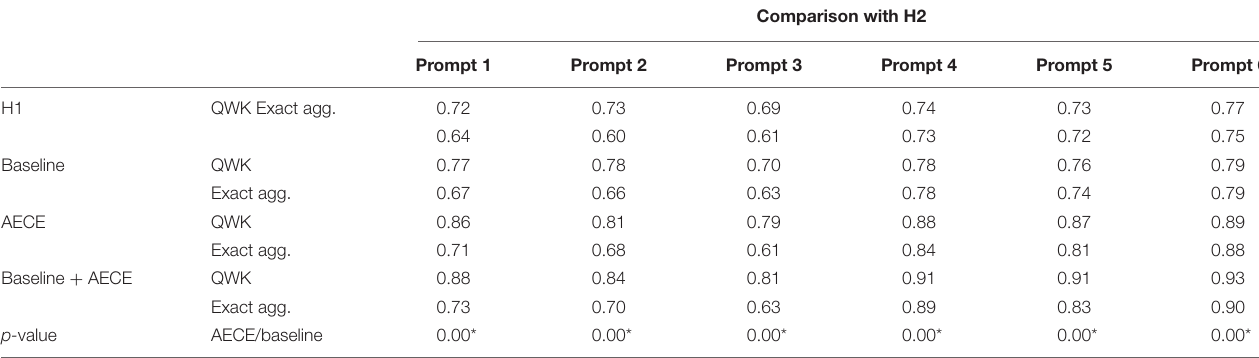
TABLE 3 | QWK and exact agreement of human raters (H1/H2) and H2/AECE holistic score, p values are computed for